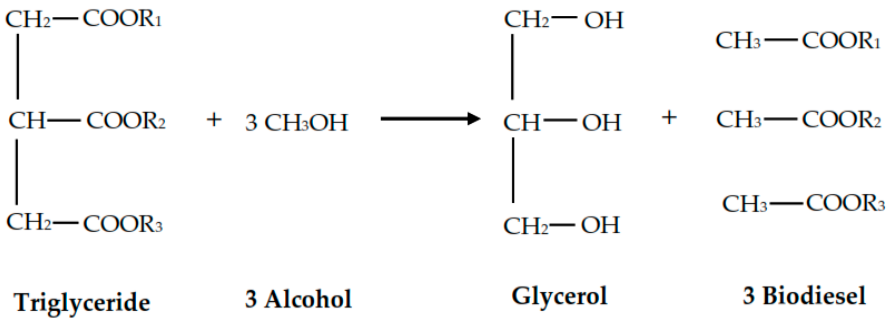
Figure 3. Triglyceride reaction with an